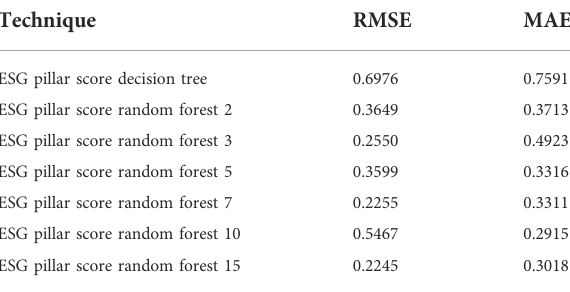
TABLE 10 ESG pillar score error measurement using the decision tree and random forest technique. Technique